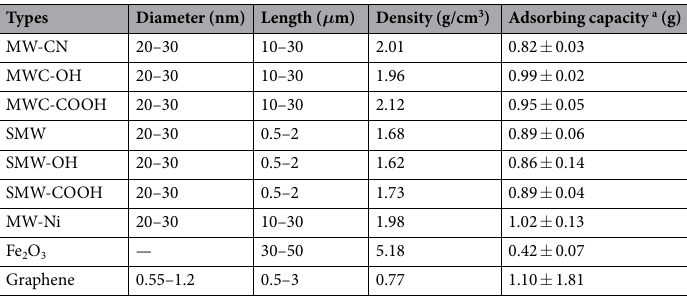
Table 1. Different physical parameters of the immobilized supporters. a: Reaction condition: the temperature was 50 °C; the enzyme powder was confected in 20 g/L by 2 mL disodium hydrogen phosphate-citrate buffer (pH 7); the nanoparticles mass was 10 mg; the reaction time was 3 h; the mixture was stirred at 120 rpm in an incubator